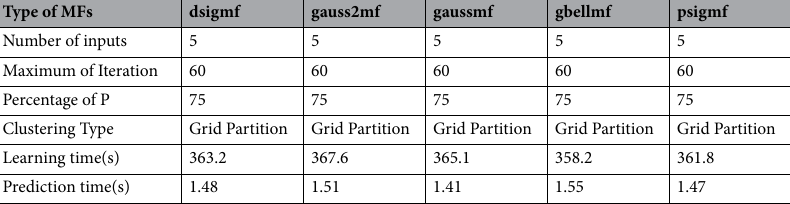
Table 8. ANFIS performance.